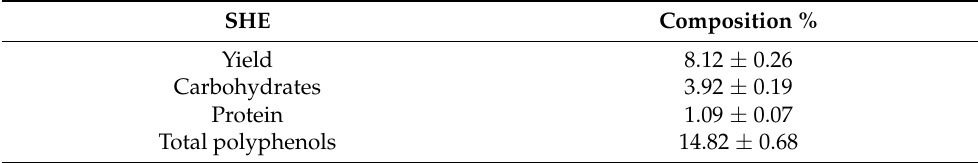
Table 1. Composition of SHE.